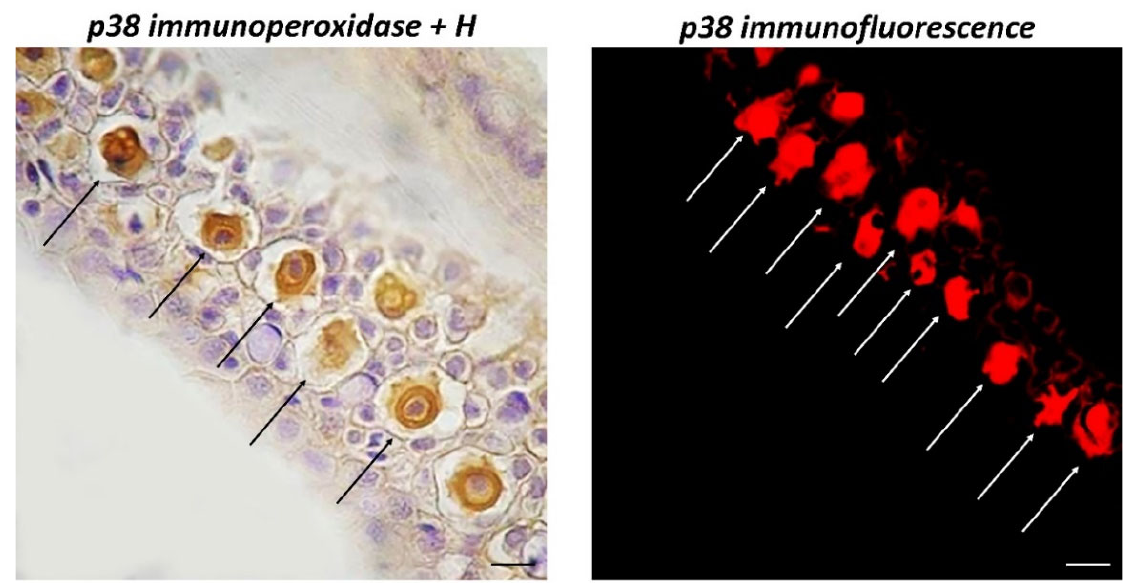
Figure 2. Longitudinal sections (5 μ m thick) of zebrafish skin, Sections are immunohistochemically treated with MAPK p38. Immunoperoxidase counterstained by H, 100×, scale bar 100 μ m. Immunofluorescence, 40×, scale bar 40 μ m. Immunoreactive CCs for MAPK p38 (arrows) appear evident, with a large core centrally located. They are well organized in the intermediate epidermal layer as shown by counter colouring with H.